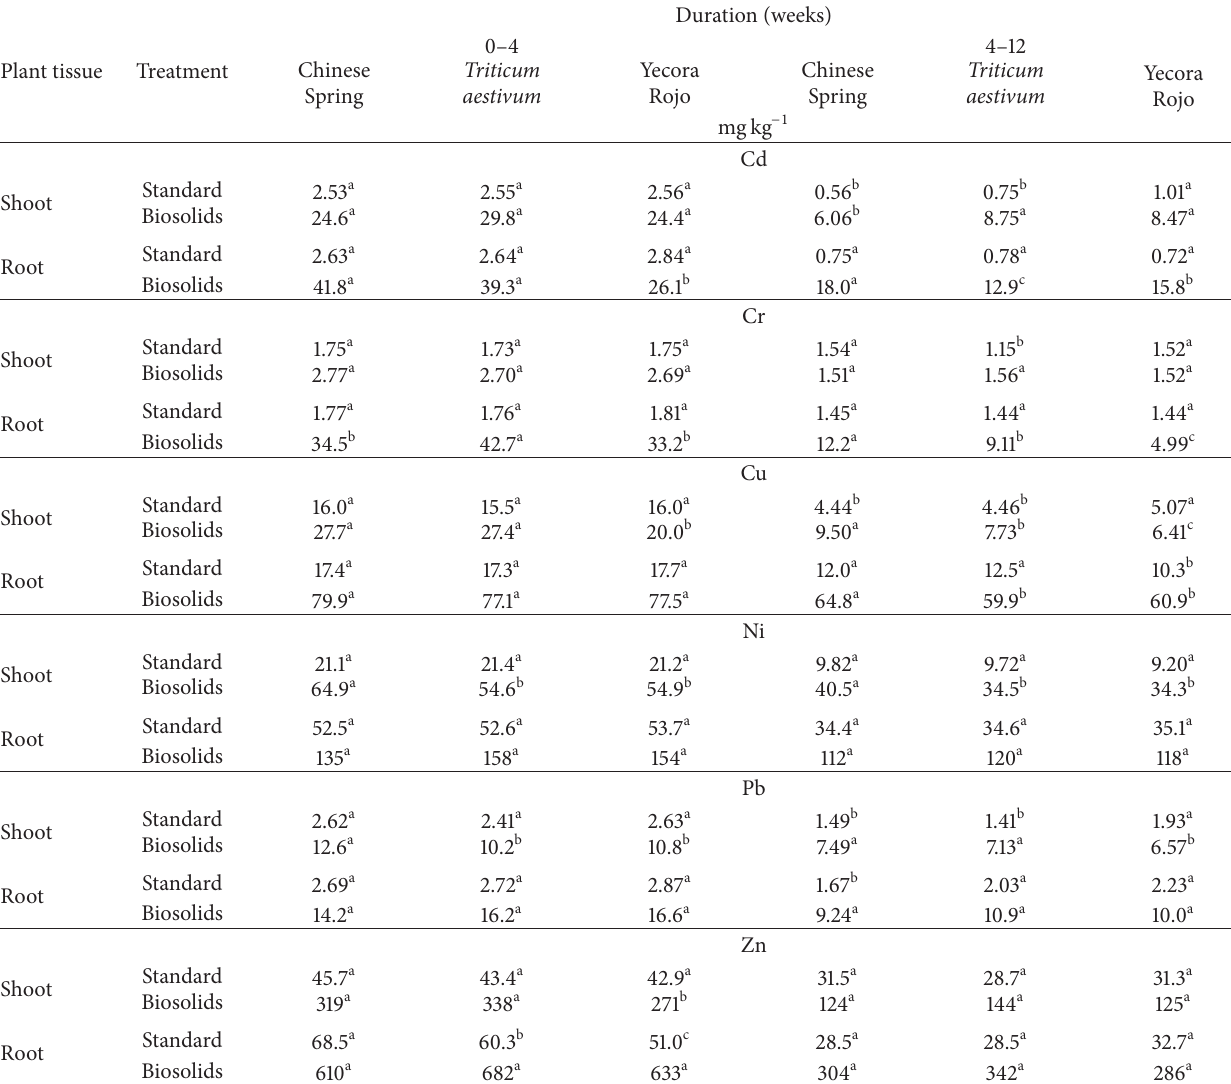
Table 3: Metal concentrations (means where 𝑛 = 4 ) of three wheat cultivars grown on sand media amended, without biosolids (Standard) and with biosolids † .